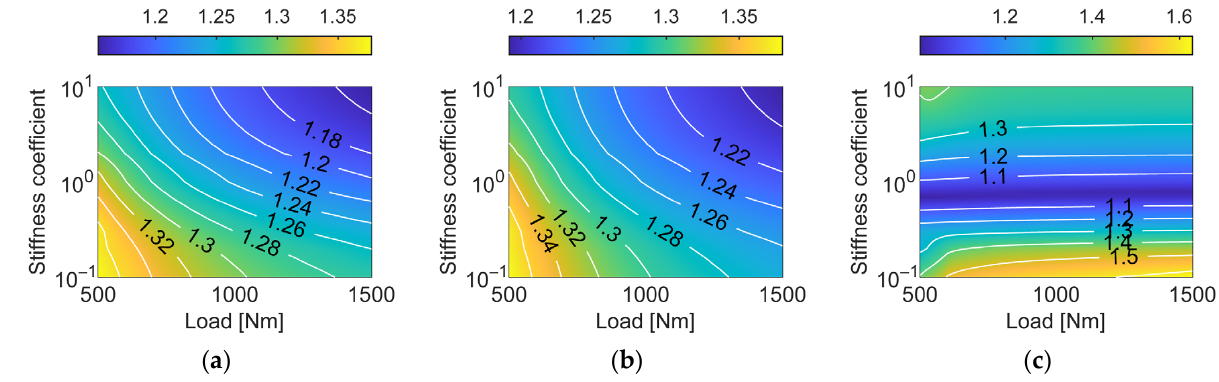
Figure 17. Influence of support stiffness of Idler 2 on load-sharing coefficient: ( a ) Input Gear 1; ( b ) Input Gear 2; ( c ) idler gear.